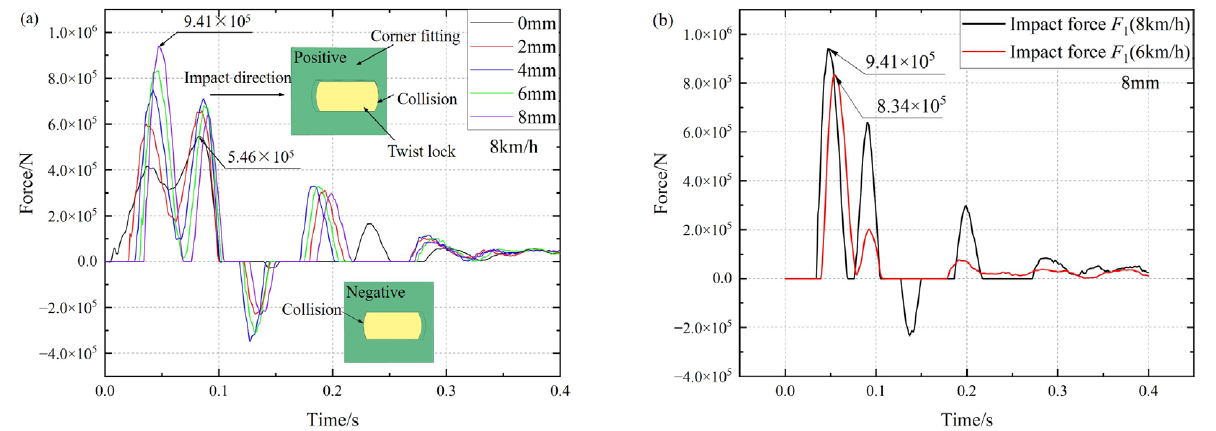
Figure 13. The variation in F 1 over time: ( a ) at different initial clearance; ( b ) at different initial velocities.